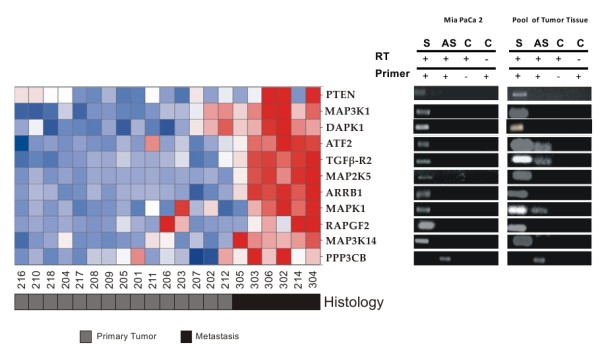
LncRNAs deregulated in pancreatic cancer metastasis map to intronic regions of genes associated with the MAPK pathway and/or related to apoptosis. Transcriptional orientation of eleven intronic lncRNAs mapping to MAPK pathway and/or apoptosis-related gene loci (ARRB1, ATF2, MAPK1, MAP2K5, MAP3K1, MAP3K14, PPP3CB, RAPGF2, TGFβR2, DAPK1 and PTEN) was investigated by strand-oriented reverse transcription followed by PCR. For each gene, sense (S) or antisense (AS) transcription was measured. Controls (C) for the absence of self-annealing during reverse transcription (RT) were obtained by performing RT reactions in the absence of primers (RT+, Primer -). Controls for the absence of genomic DNA contamination were obtained by omitting reverse transcriptase in the RT reaction (RT-, Primer +).